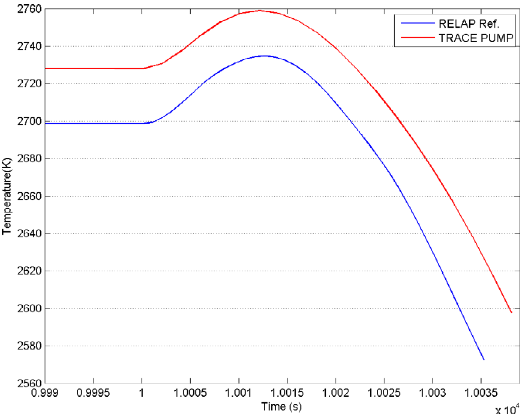
Fig. 12. HFA fuel temperature (1D).